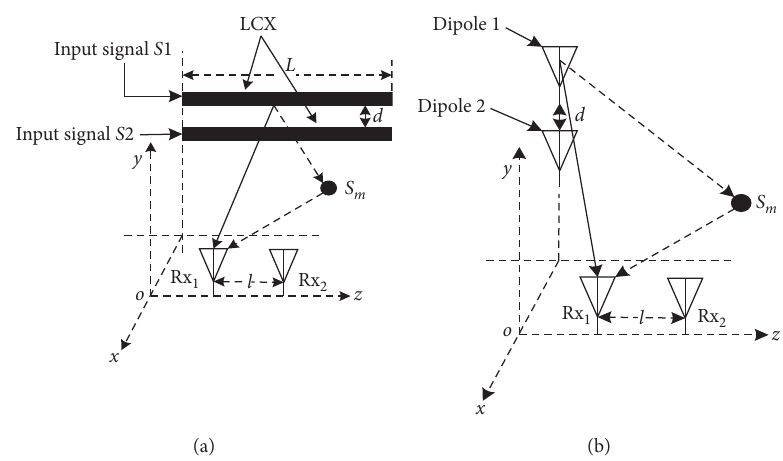
Figure 4: Simulation propagation scheme of MIMO system: (a) LCX-MIMO and (b) dipole